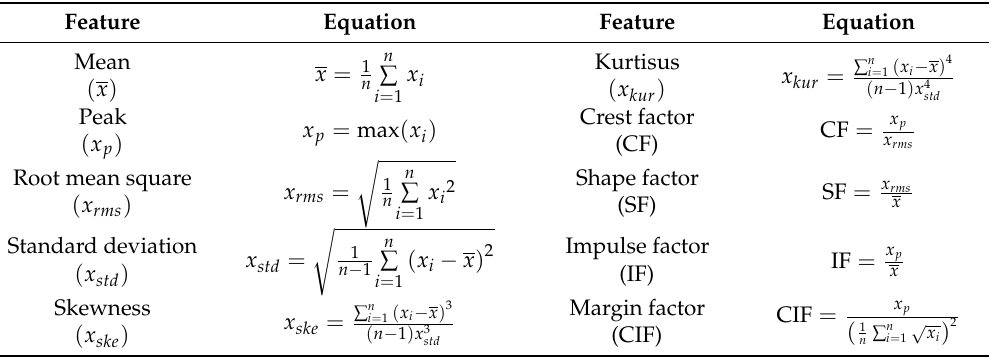
Table 1. Time domain features.